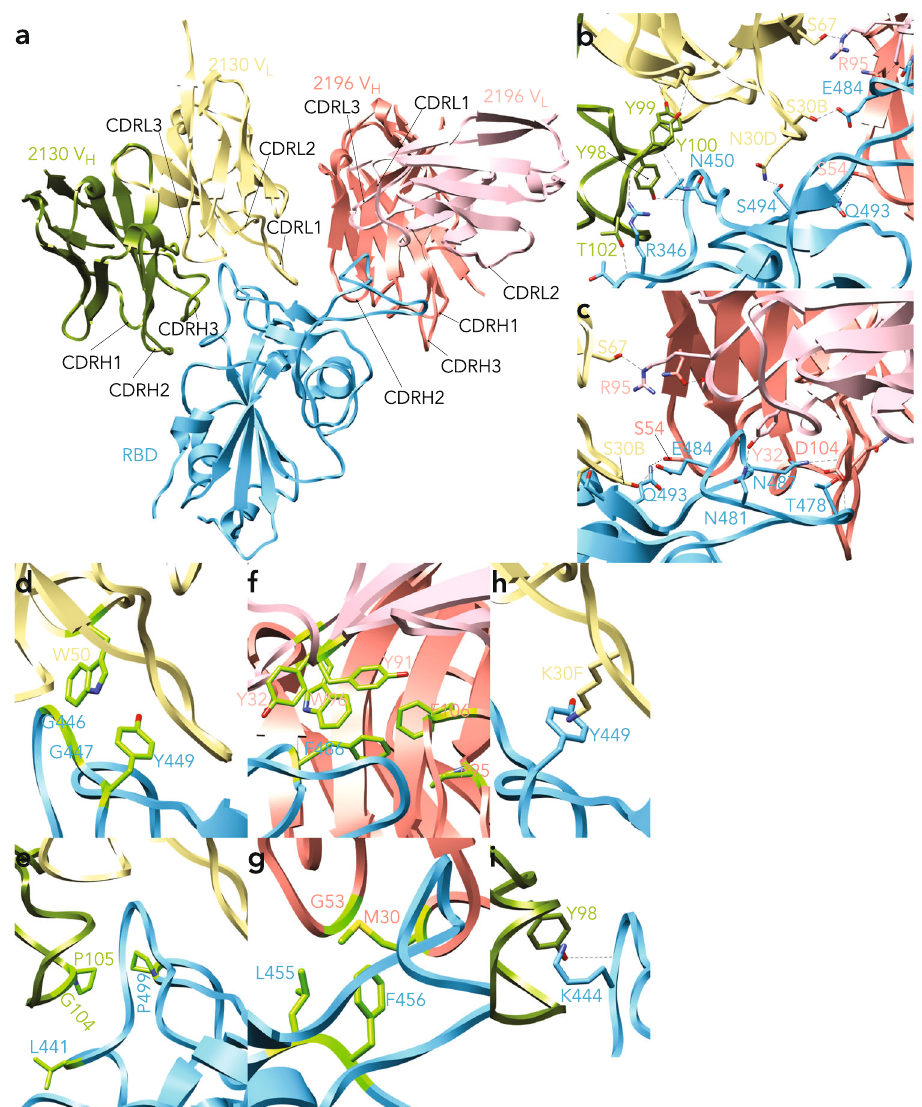
Fig. 7 | Structural details ofthe diverse interactions between in vivo-produced dFabs and the SARS-CoV-2 (USA-WA1/2020) spike trimer. a Structural overview of RBD (blue)in complex with both 2196 (V L inpink;V H insalmon)and 2130 dFabs (V L ingold;V H ingreen). b 2130interactionswithRBDmainchainpartners(CDRH3 T102 to RBD R346 peptide bond; RBD 346 to CDRH3 Y100 peptide bond; CDRH3 Y98 top to RBD V445 peptide bond; RBD N450 to CDRH3 Y100 peptide bond) and side chain partners (CHRL1 N30 to RBD S494 and CDRL1 to S30B to RBD 484E). c 2196interactionswithRBD(Q493engagesCDRH2S54,RBDN481engagesCDRL1